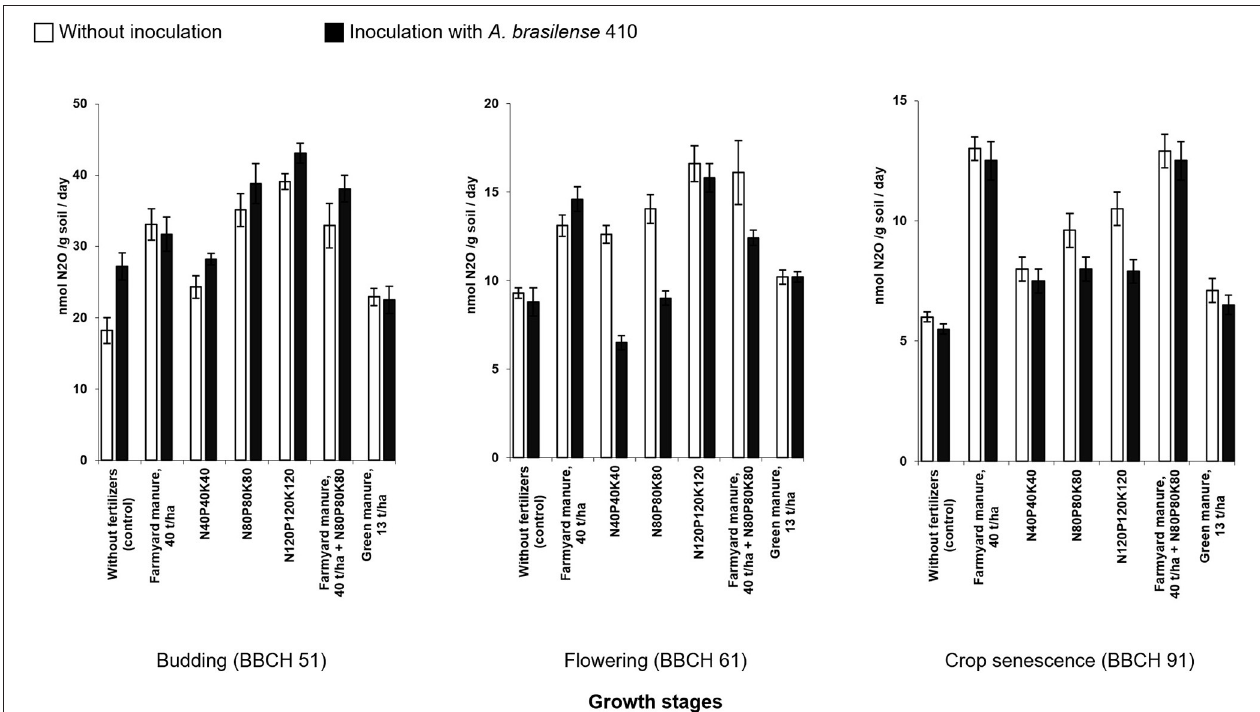
FIGURE 2 | Potential activity of N 2 OD emissions in the rhizosphere soil of potato plants under the action of fertilizers and microbial inoculation with A. brasilense 410 (2018) (bars indicate standard deviation) .